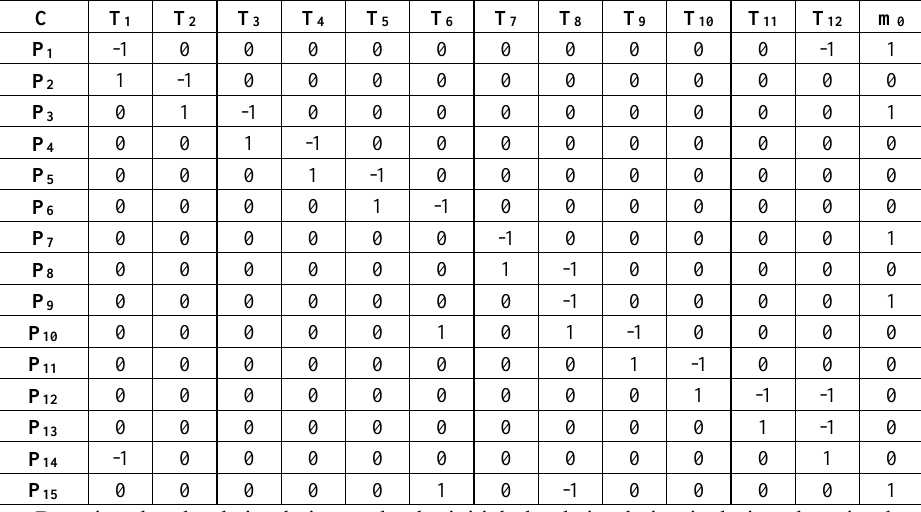
Table 3. Matrix for abstract model of